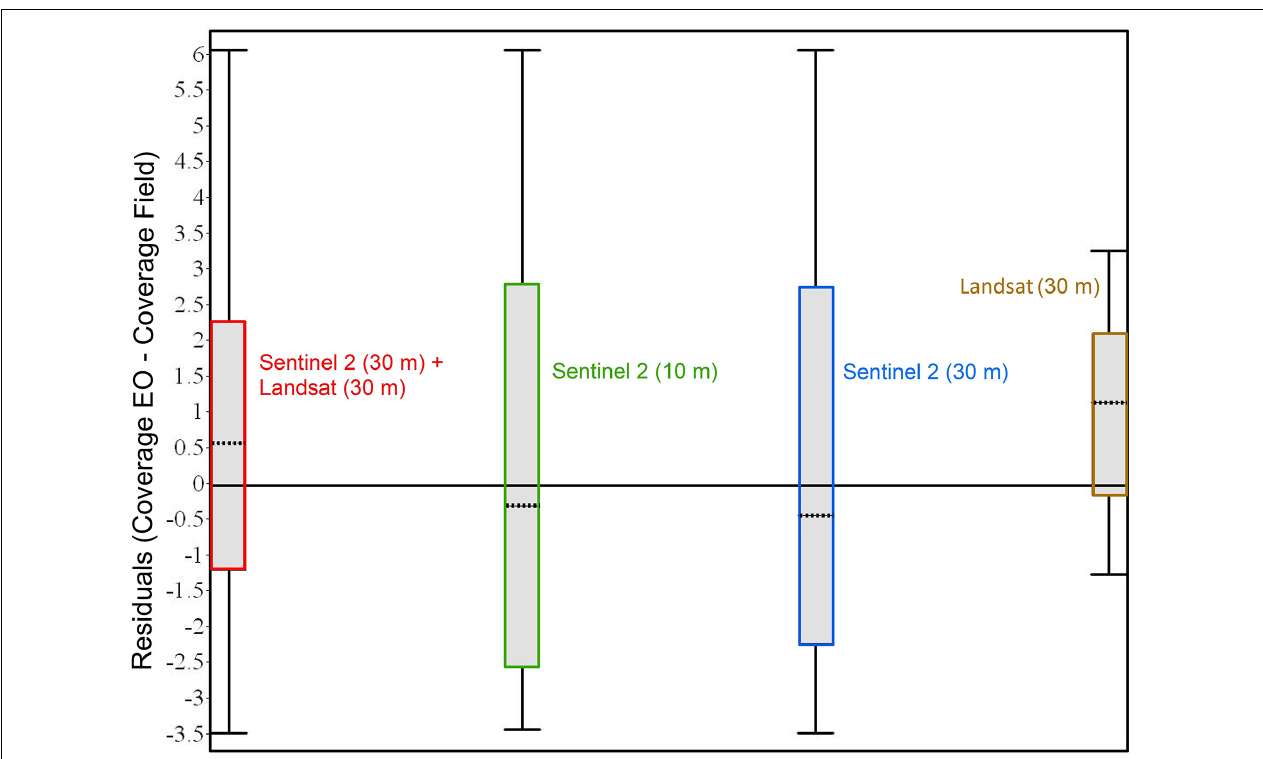
FIGURE 6 | The box plots showing the residuals computed between the EO estimates and field coverages. The upper and lower bounds of the box represent the first and third quartiles, whereas the dotted line represents the median. The long horizontal line shows the zero value. The whisker shows the range of the residual data.